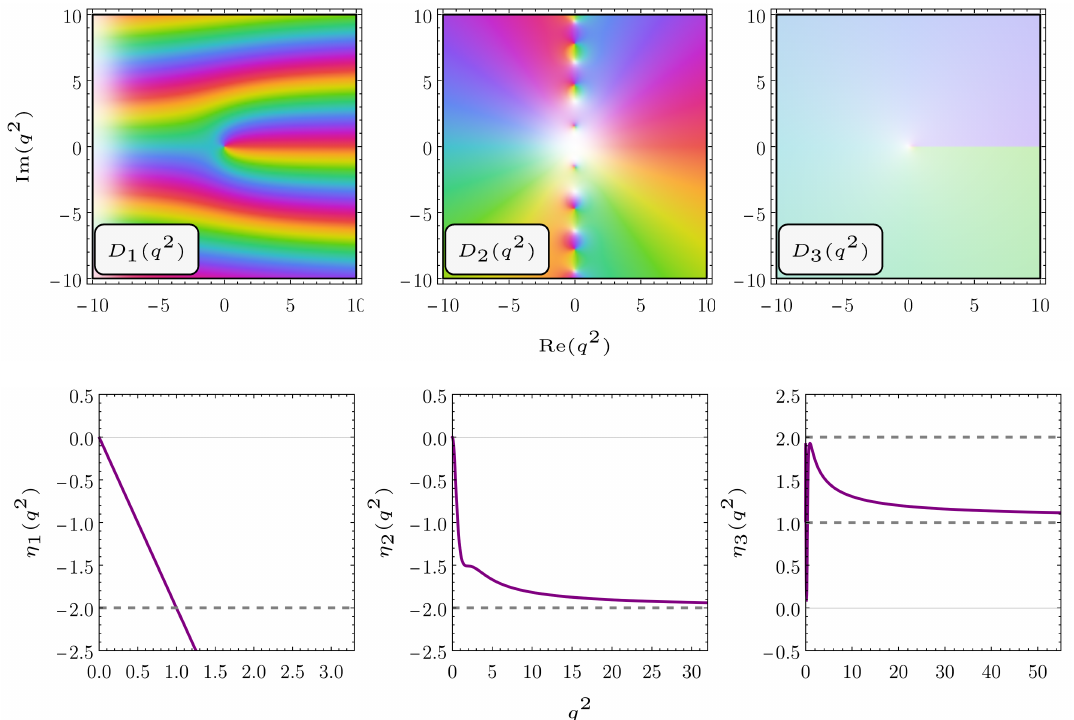
Figure 23 . Pole structure in the q 2 -complex plane (top panel) and anomalous dimension η i for the propagators D (figures on the left), D (figures in the center), and D (figures on the right). 1 2 3 Aside from the massless pole at q 2 = 0 , the propagator D does not have additional poles but has 1 an essential singularity at infinity. Its anomalous dimension varies from zero to negative infinity. In contrast to the case of D , the anomalous dimensions associated with the propagators D and D 1 2 3 are bounded from above and from below. Yet, D and D display a very different pole structure: the 2 3 first has no branch cut singularities and is characterized by a tower of massless complex-conjugated poles, while the second does not have poles beyond the massless one and has instead a branch cut for q 2 > 0